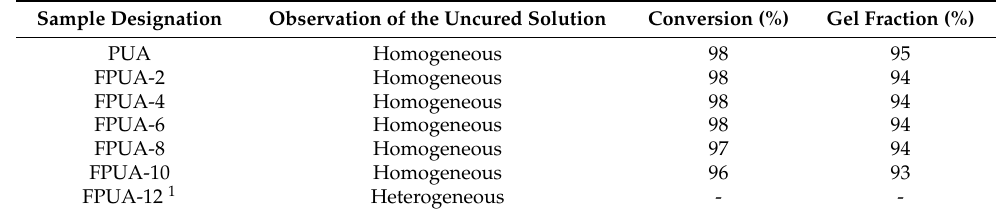
Table 2. Degree of C=C conversion and gel fraction of the UV-LED curable